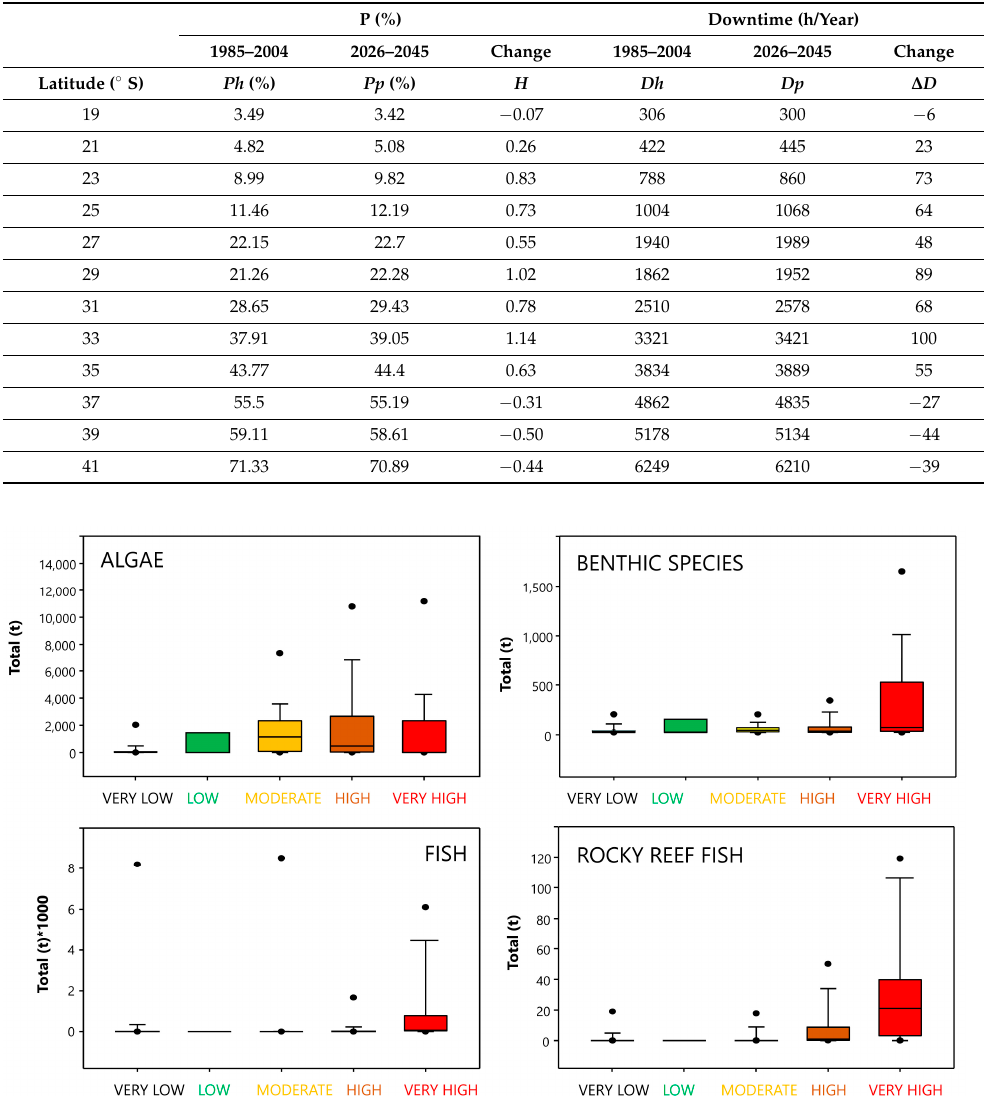
Table 4. Exceedance probability and downtime (in h/year) associated with a threshold of 𝐻𝑠 = 2.0 m for the historical period (1985–2004) and for the projection (2026–2045), lumped every 2° of latitude in regions exposed to ocean swells.